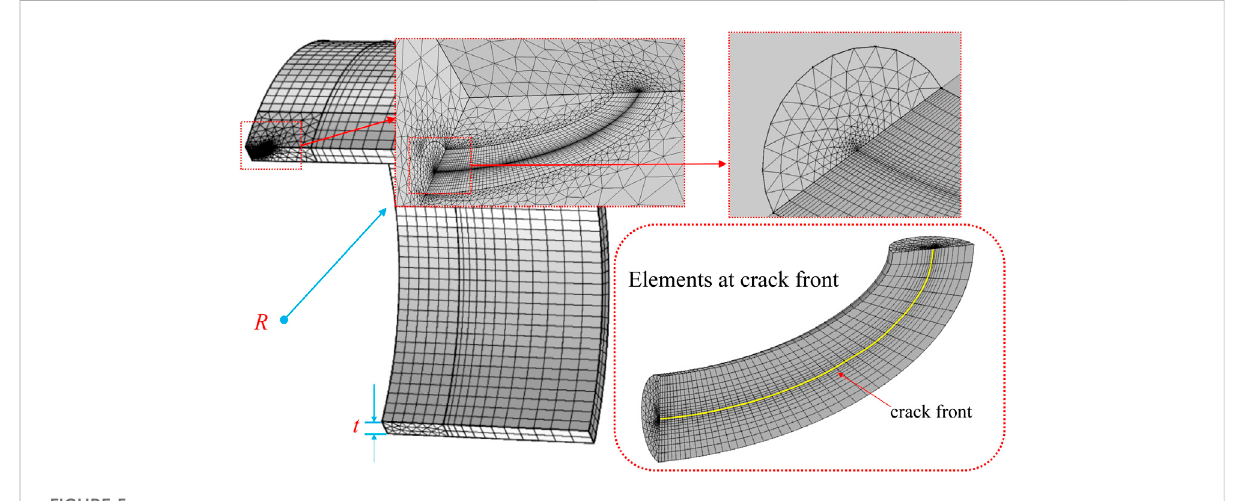
FIGURE 5 Finite element model and the